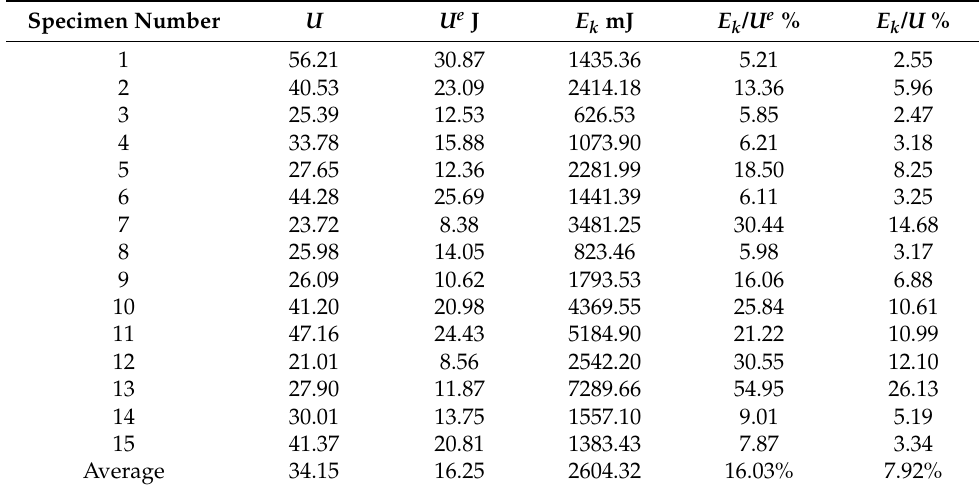
Table 6. Input energy, elastic energy and kinetic energy of different